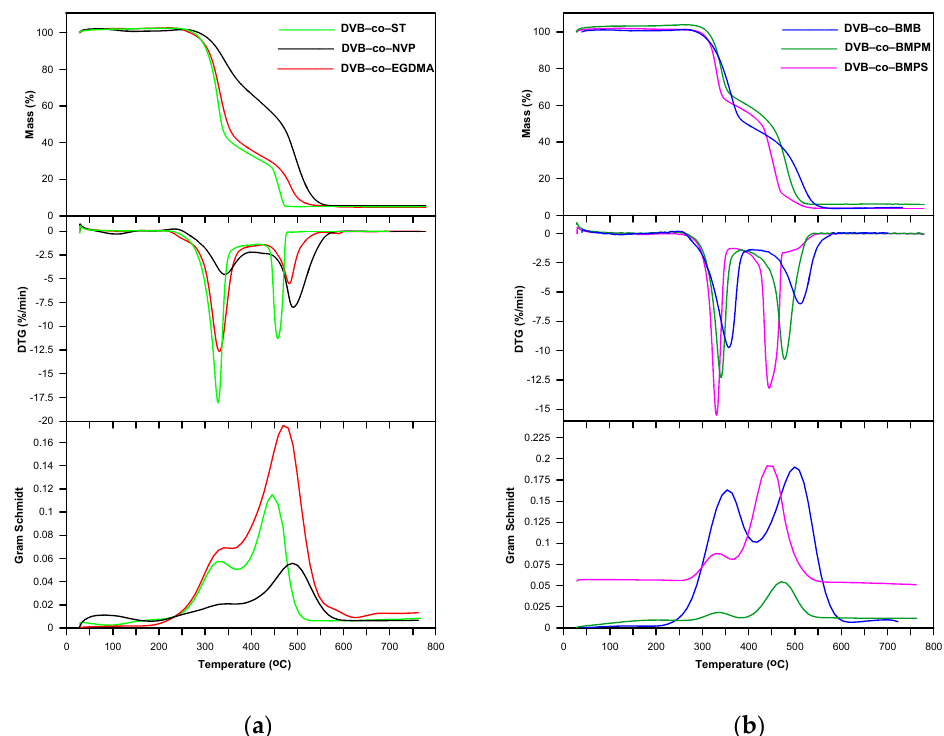
Figure 8. TG, DTG and Gram–Schmidt curves of copolymers obtained under air atmosphere. ( a ); DVB- co -ST, DVB- co -NVP and DVB- co -EGDMA; ( b ) DVB- co -BMB, DVB- co -BMPS and DVB- co - BMPM.